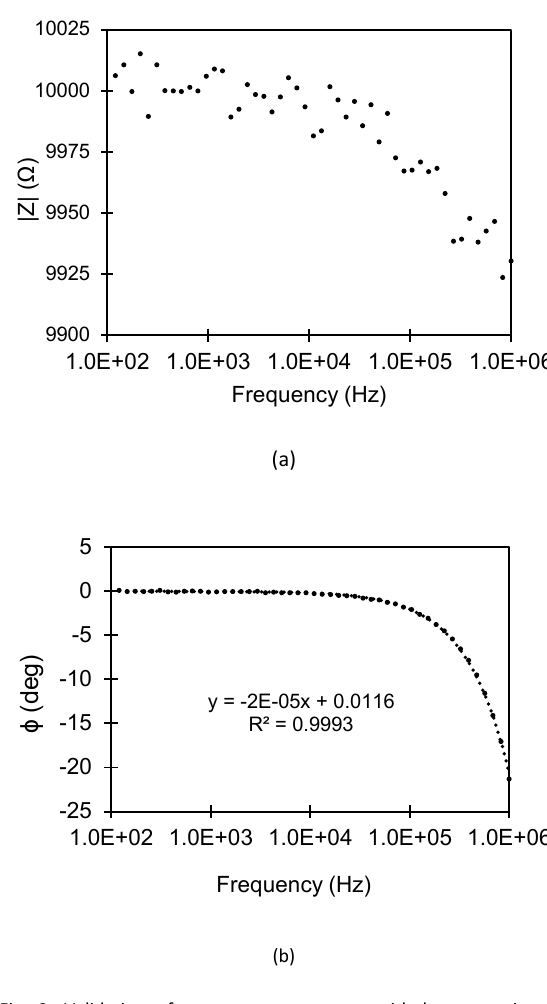
Fig. 3. Validation of measurement system with known resistor values. (a) Modulus values of a control 10 kΩ resistor. (b) Phase angle values of a control 10 kΩ resistor. Phase angle measurements exhibit linear dependency on frequency with slope